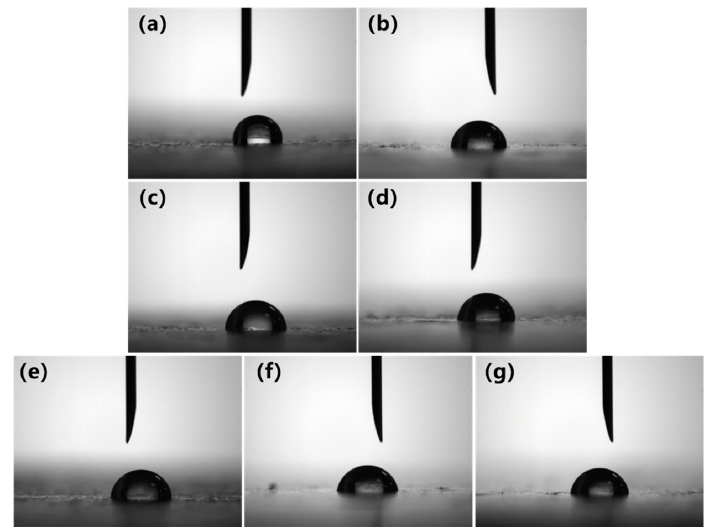
Figure 6. Surface contact angle images of the PVC modified by cPAM: ( a ) PVC, ( b ) PVC / cPAM, ( c ) PVC / cPAM-3, ( d ) PVC / cPAM-6, ( e ) PVC / cPAM-9, ( f ) PVC / cPAM-12, and ( g ) PVC /